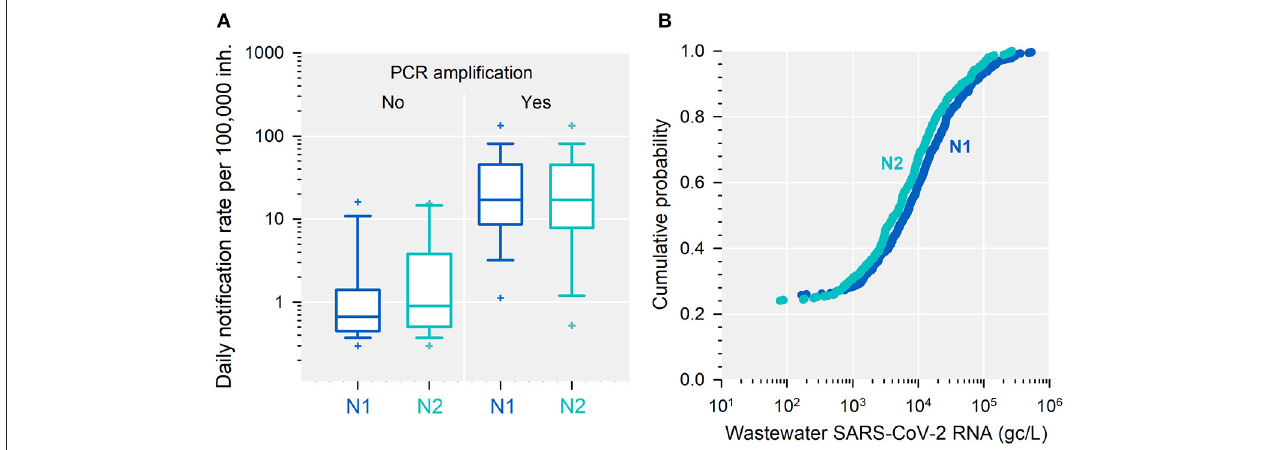
FIGURE 1 | SARS-CoV-2 detection limit in wastewaters. (A) Box plot of daily notification rates per 100,000 inhabitants for wastewater samples that yielded an RT-qPCR product, vs. those that failed to amplify. Data are shown separately for viral genome regions N1 and N2. Boxes show the 25th, 50th (median), and 75th percentiles. Error bars indicate the 10th and 90th percentiles, and crosses show the 5th and 95th percentiles. (B) Cumulative probability distribution of the estimated viral RNA concentration for genome regions N1 and N2. Based on this distribution, the detection limit of the RT-qPCR was approximately 100